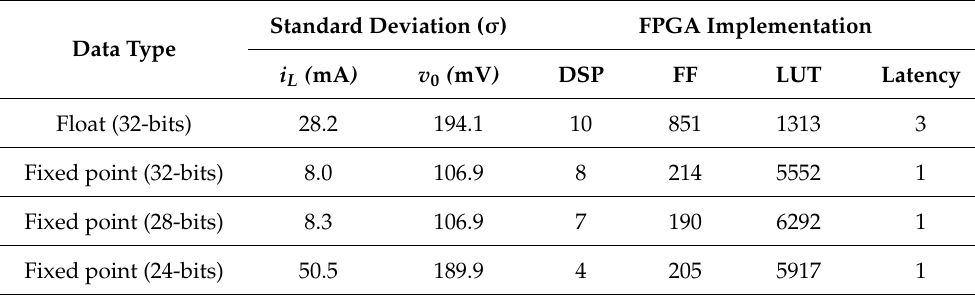
Table 1. Summary of simulation results and synthesis of the totem-pole converter. Standard Deviation ( σ ) FPGA Implementation Data Type i L ( mA ) v 0 ( mV ) DSP FF LUT Float (32-bits) 28.2 Fixed point (32-bits) 8.0 Fixed point (28-bits) 8.3 Fixed point (24-bits) 50.5